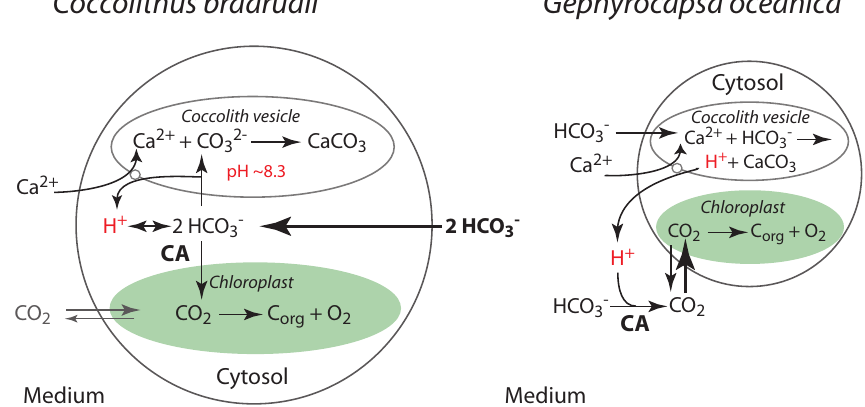
Fig. 8. A schematic to illustrate our conceptual model which proposes that the C source for photosynthesis dictates what happens to the H + from calcification may to account for differing responses of species of coccolithophore to changing pH and CO 2 availability. We show two different extreme endmembers for our conceptual model and it is most likely that species and even strains consist of a proportional mixture of the two processes but lie along a gradient between them. The curved arrows at the membrane of the calcification vesicle represent the Ca 2 + /H + ATP-ase (Arako and Gonzalez,